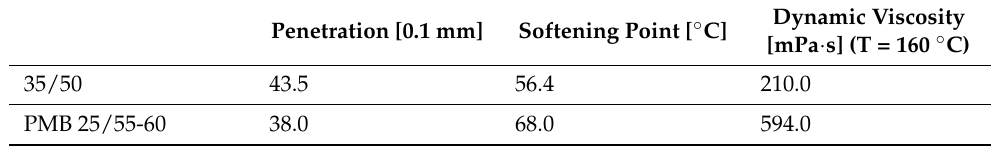
Table 1. The properties of the used